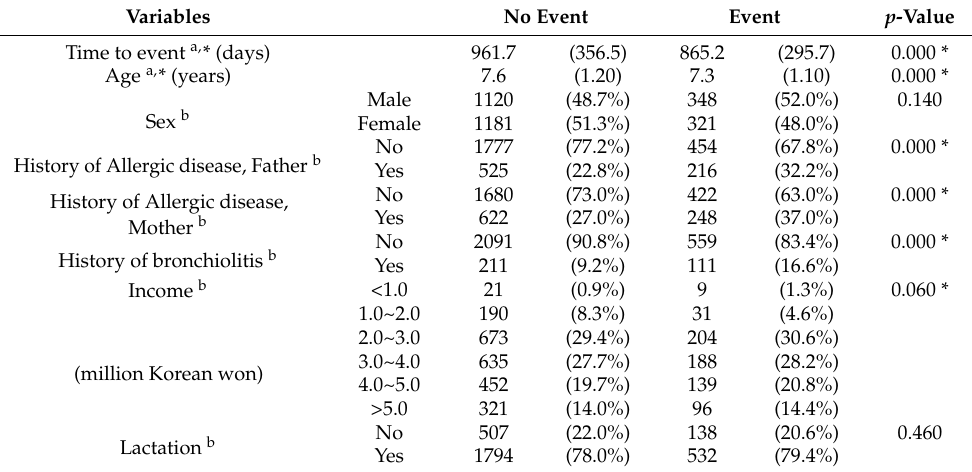
Table 1. Demographic features of subjects focused on intrinsic factors § .